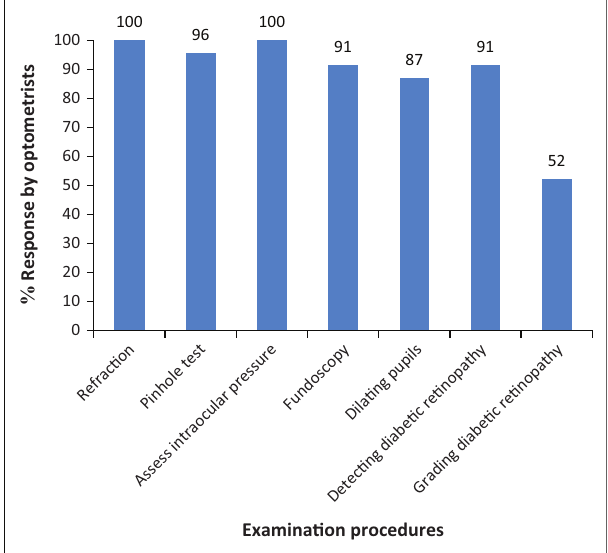
FIG URE 6: Percentage of competency level of optometrists in conducting examination procedures.